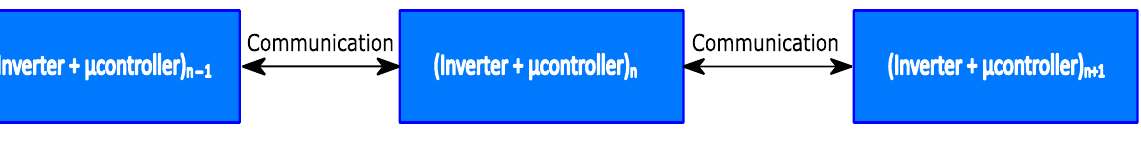
Figure 8. Communication pathways between microcontrollers.